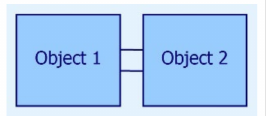
Figure 5. Assignment operation.